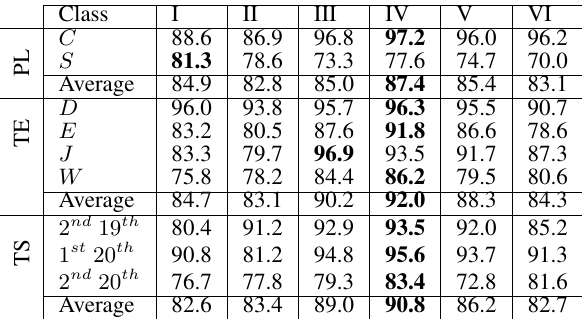
Table 3. F1-scores [%] for the properties production place (PL), production technique (TE) and production timespan (TS). For the abbreviations of class names, cf. tab. 1.